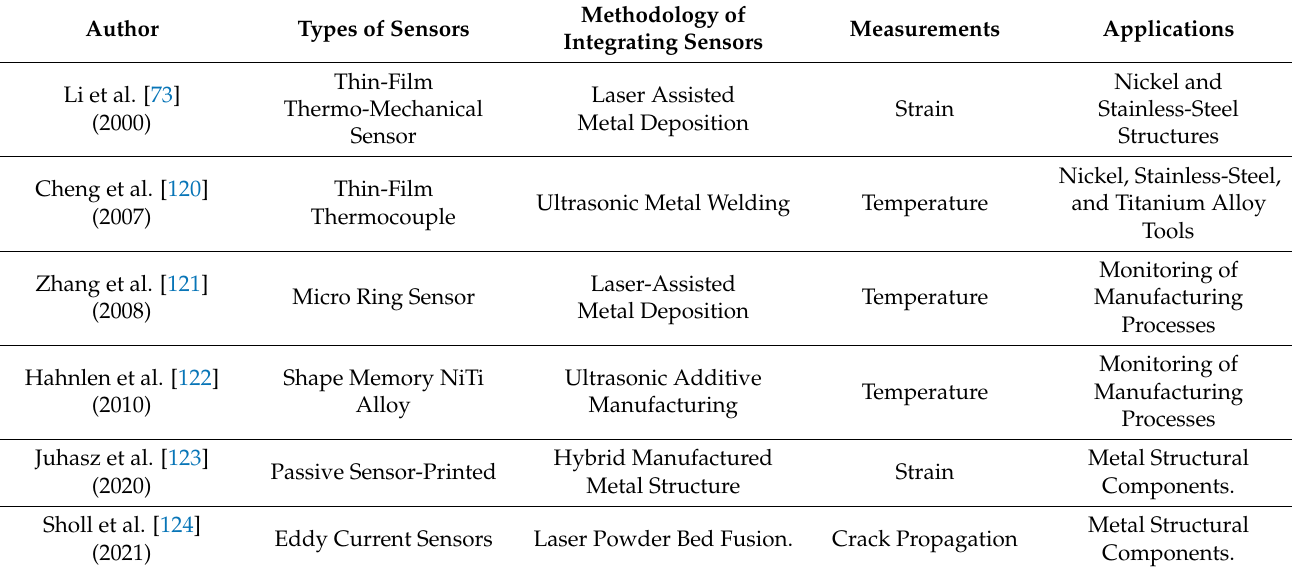
Table 9. Overview of applications, type of embedded sensors used, and methodology of integrating sensors for metal structural